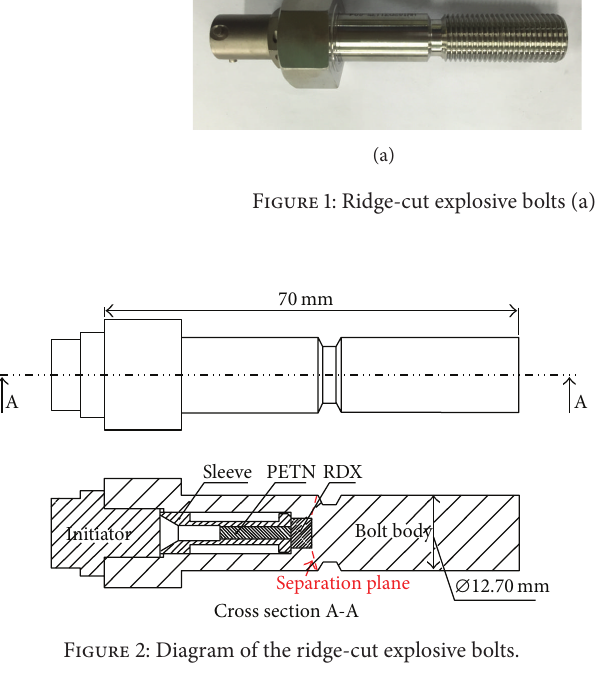
circular plates, respectively, 11 mm, 50 mm, and 90 mm away from the center of the plates. In the LDV controllers, a band pass filter with a passing frequency from 100 Hz to 100